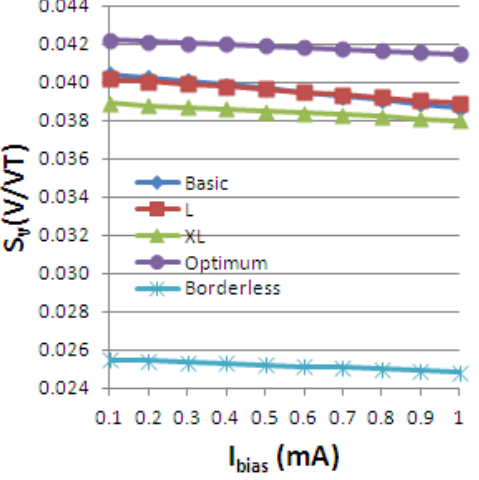
Figure 21. Voltage-related sensitivity of the simulated Hall Effect